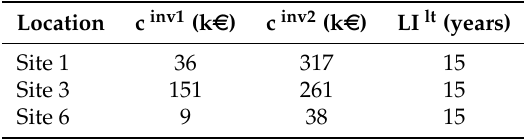
Table 5. Potential mechanical vapour recompression and their investment